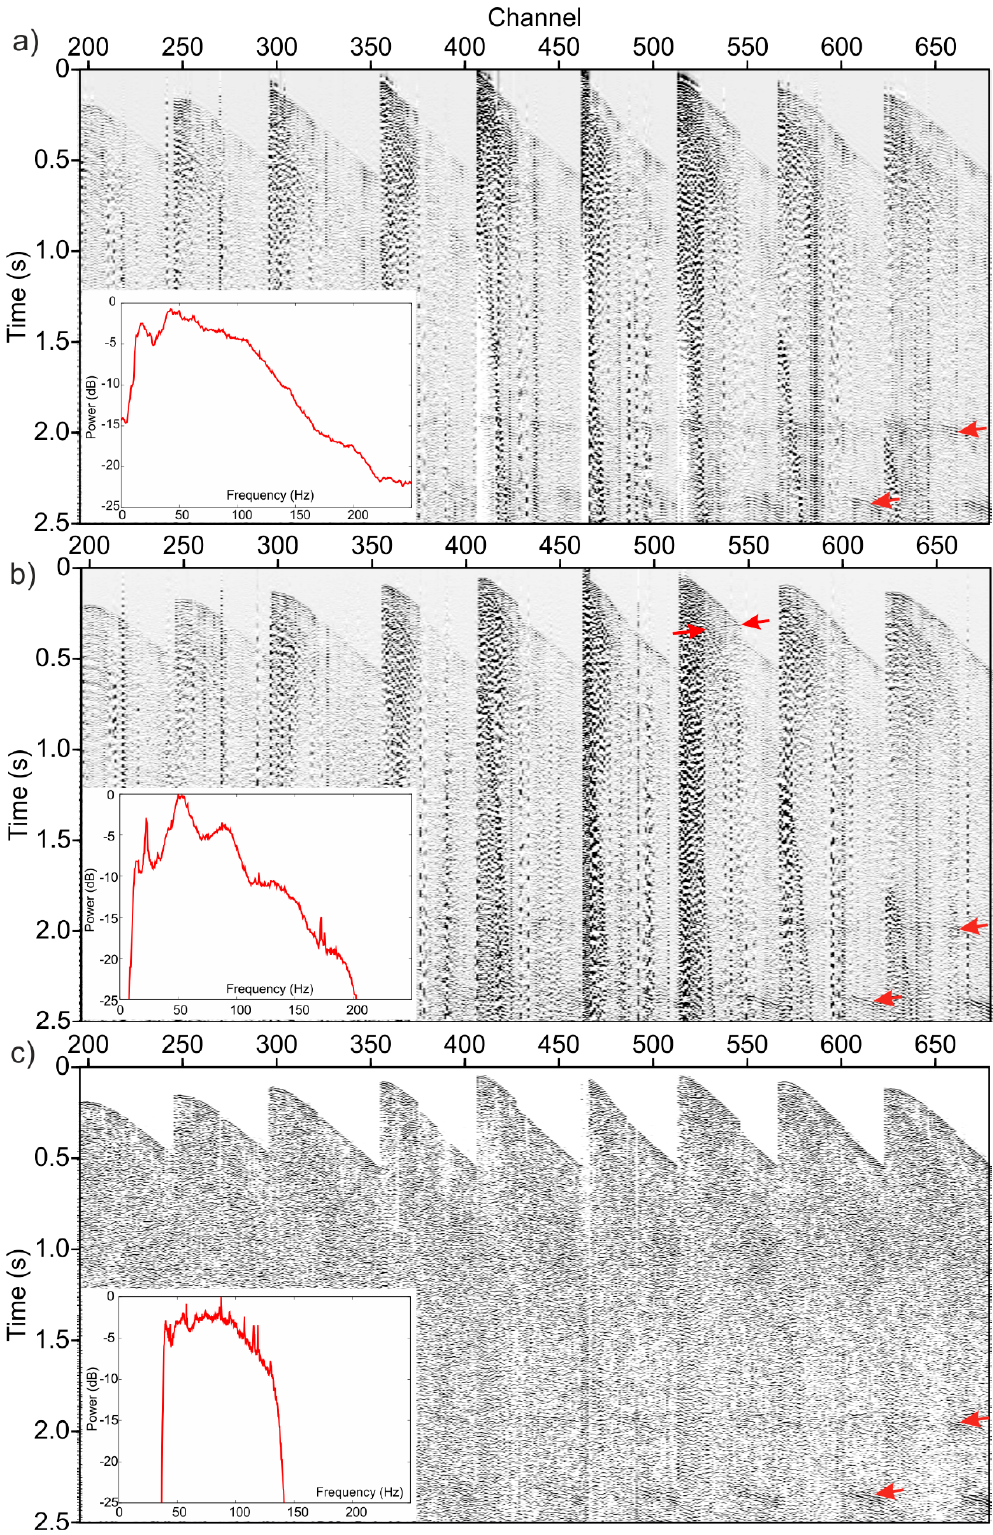
Figure 2. Comparison of shot gathers from a co-located dynamite and Vibroseis shot. Inset shows respective frequency spectra. ( a ) dynamite; ( b ) Vibroseis; ( c ) same as ( b ) but with full processing applied (without top mute), please see Table 2. Arrows point to some shallow and deep reflections. Note that the dynamite record was filtered to match the waveform of the Vibroseis record.